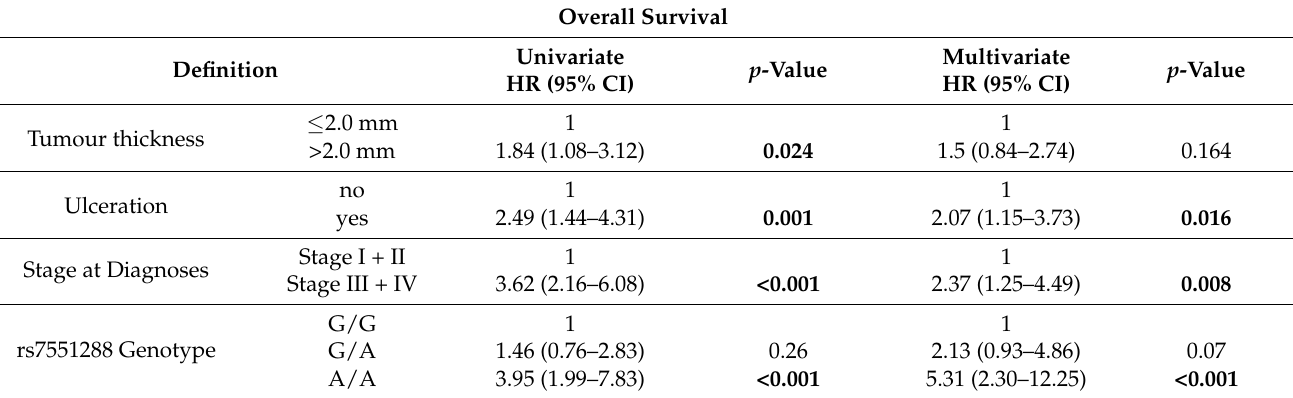
Table 3. Cox regression analyses for melanoma-specific survival. Overall Survival